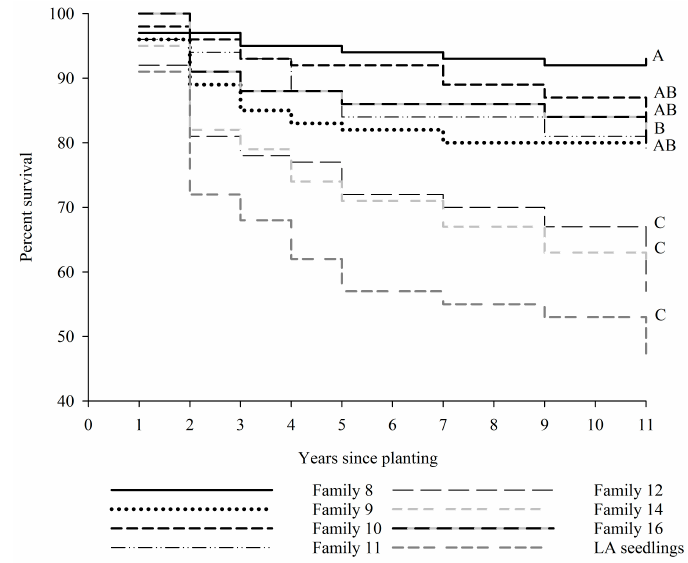
Figure 1. Mean survival among families over the 11-year study. Letters indicate differences in eleventh year survival ( α = 0.05).